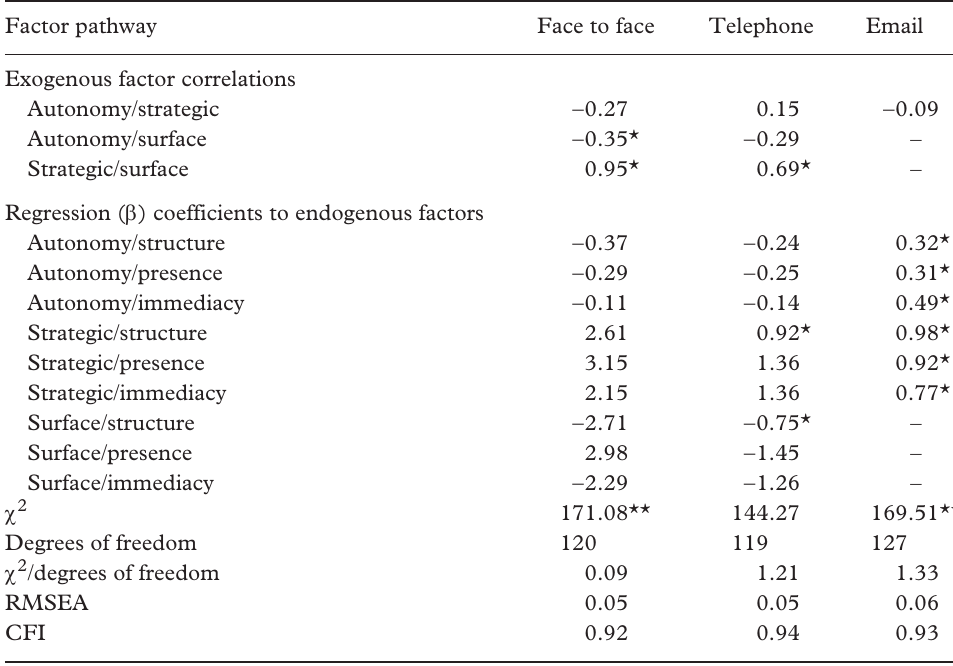
Table 2. Summary of